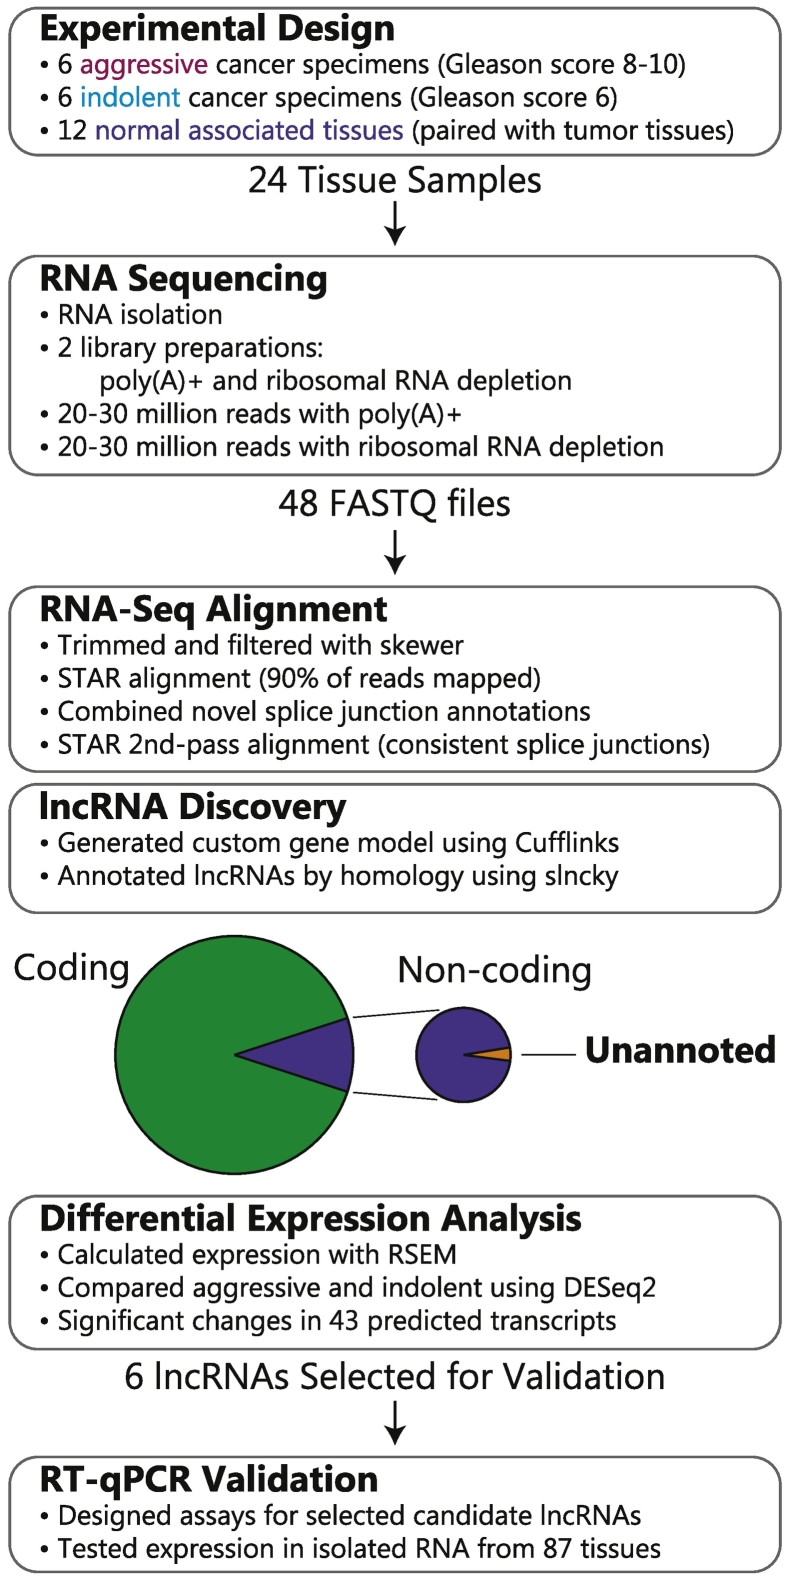
This study takes advantage of recent advances in RNA-seq analysis to discover lncRNAs present in primary tissue samples. These lncRNAs are evaluated to find candidates that are then validated using RT-qPCR.